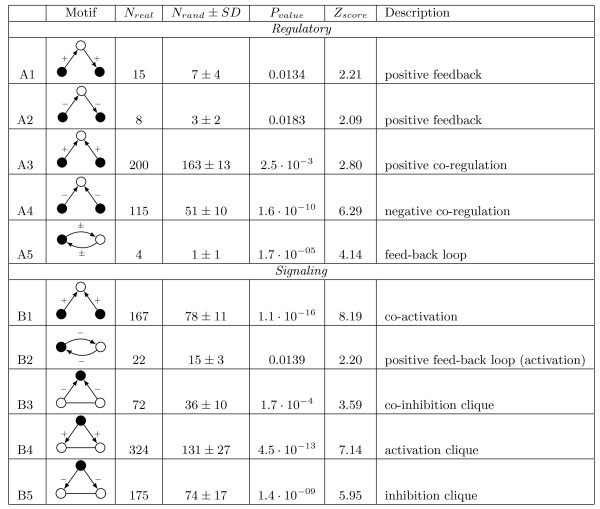
Significantly over-represented network motifs in HIV-host protein interaction network. Black nodes are HIV proteins and white nodes are human proteins. Interactions can either be activations/up-regulations (+), inhibitions/down-regulations (-), activation/inhibition/regulation (±), or both (arrow without sign). Nreal is the number of specific motifs found. Nrand ± SD is the average number and standard deviation of the motif found in one thousand randomized networks. Pvalue is the probability that Nreal or more motifs are found in the randomized networks. Zscore is the number of standard deviations Nrand differs from Nreal. Network motifs were classified as significant when Pvalue < 0.02 and Zscore > 2.